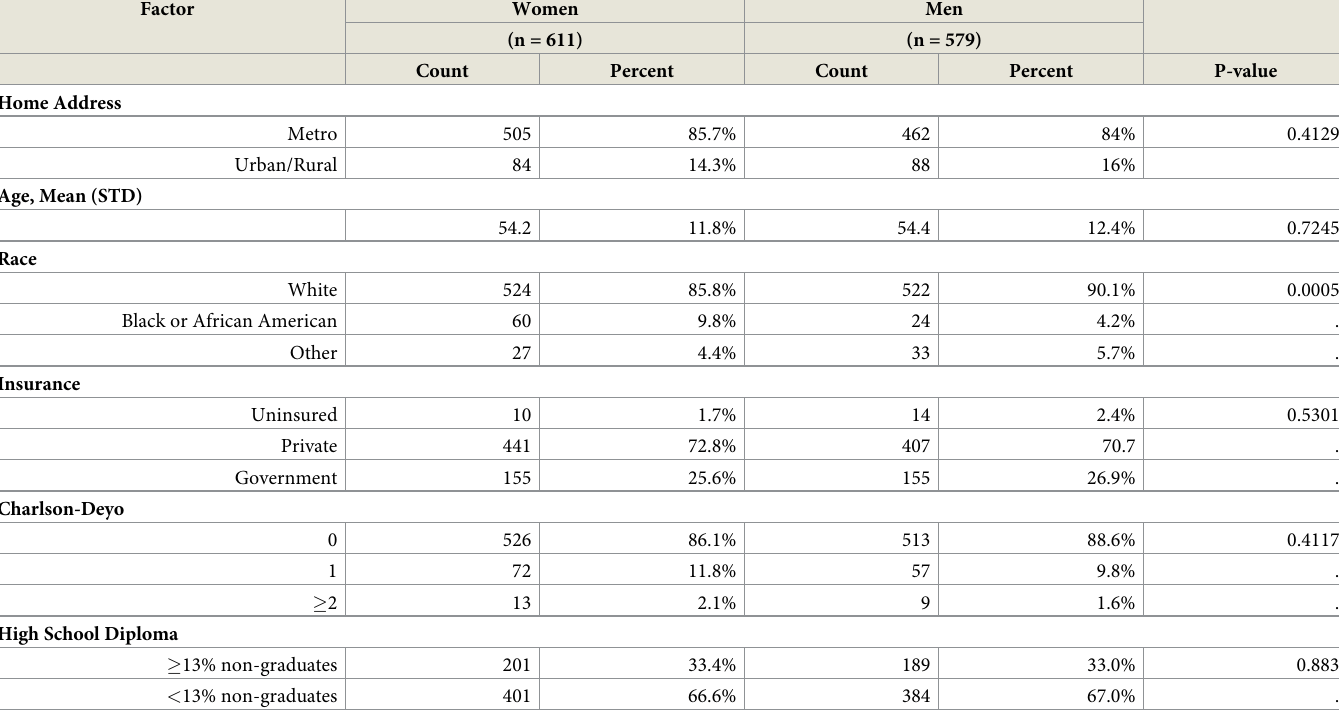
Table 1. Demographics and pre-existing comorbidities of patients undergoing HIPEC and CRS by gender.